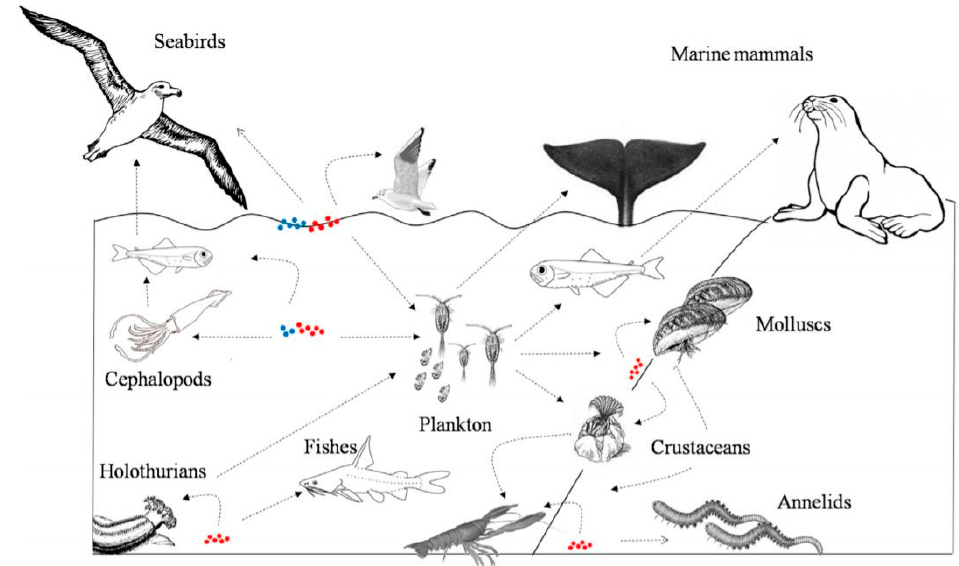
Figure 2. Schematic analysis of the trophic chain of micro-plastic in the marine environment, for explaining plastic direct and indirect ingestion [69].